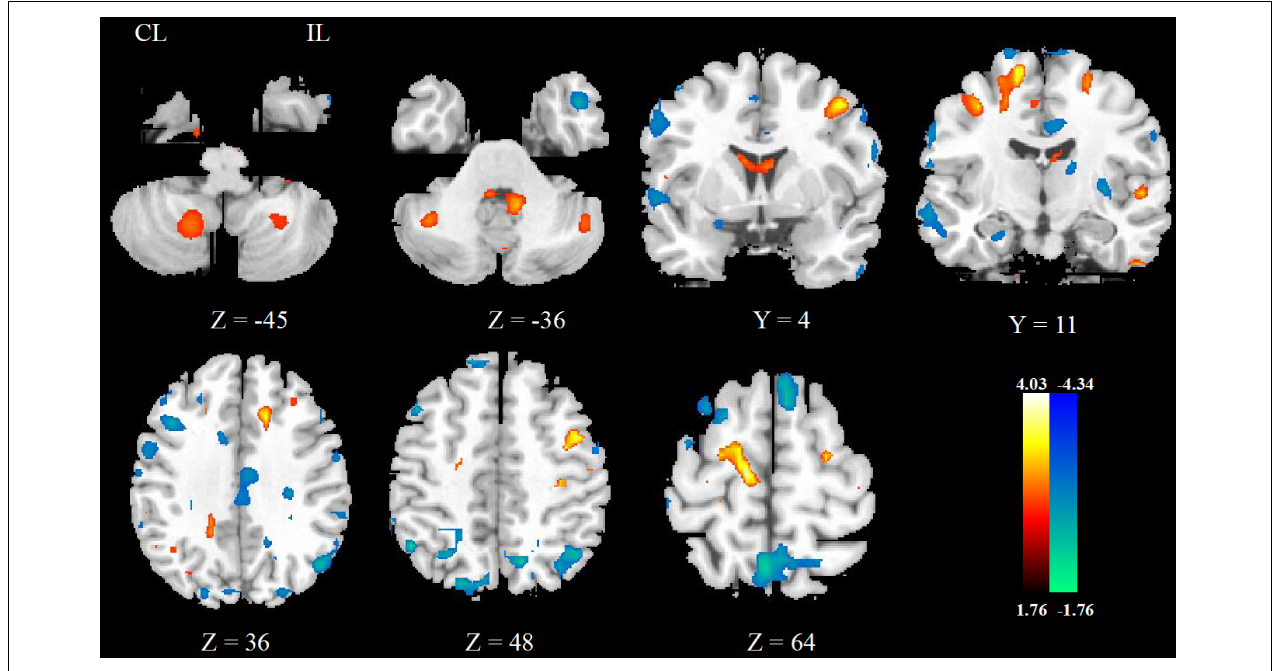
FIGURE 4 | The FA changes between pre- and post-rTMS